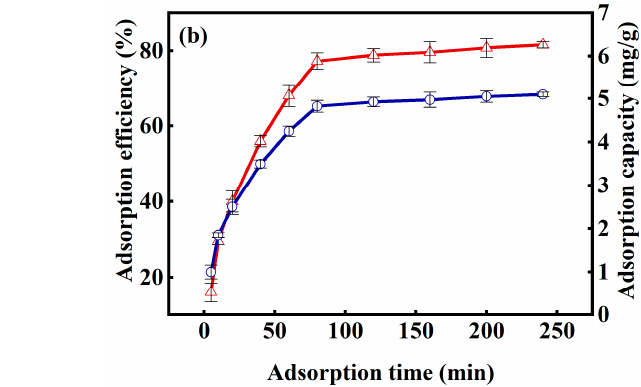
Figure 6. Influence of adsorption time on adsorption effect: ( a ) Pb ion; ( b ) Cd ion .